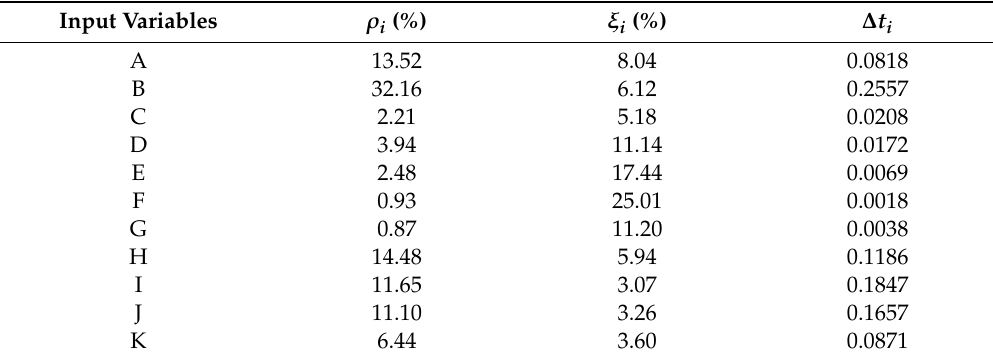
Table 3. Results of contribution rates in the first iteration.